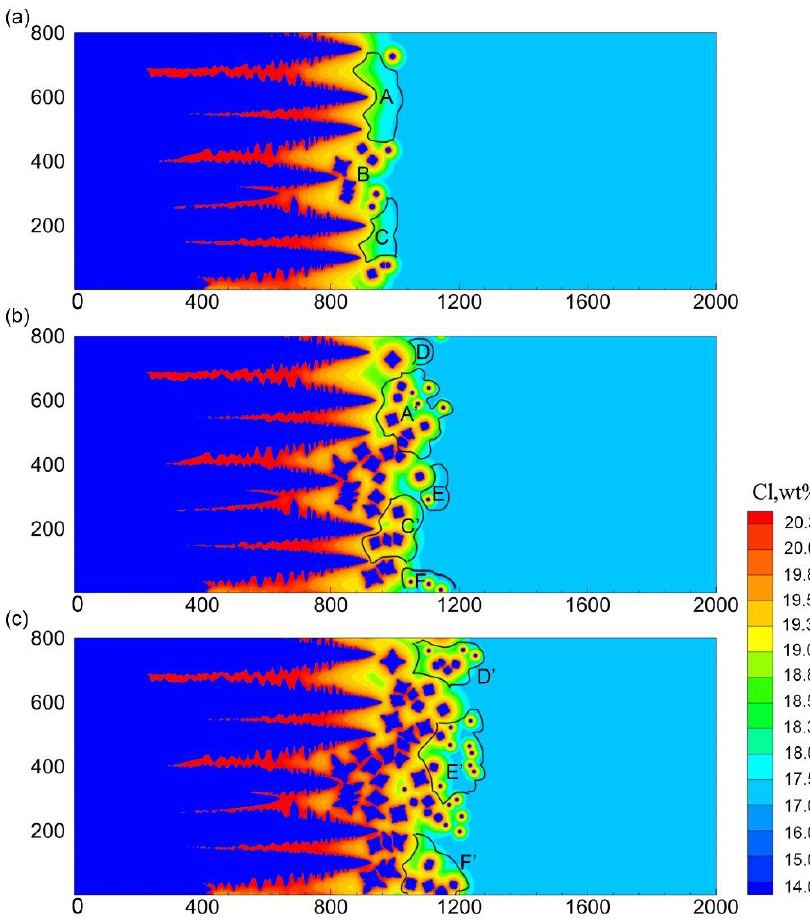
Figure 9. The solute field during the dendrite growth process when the undercooling of the crystal nucleus generator is 500 K. The solidification time from ( a )–( c ) is 6.8, 7.0, and 7.2 s, respectively.